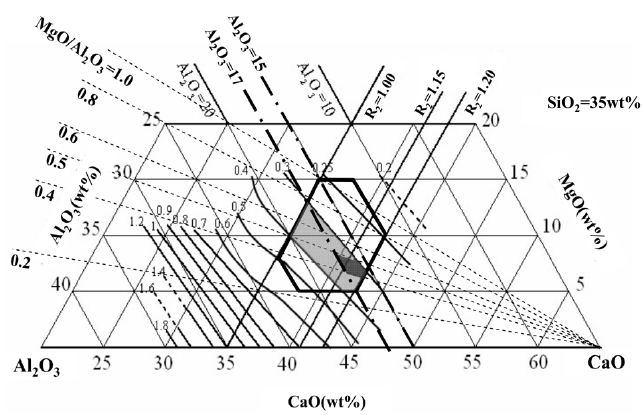
Figure 6. Isoviscosity diagram of the SiO 2 –CaO–Al 2 O 3 –MgO quaternary slag system (SiO 2 = 35%, 1500 °C, Pas) [1].